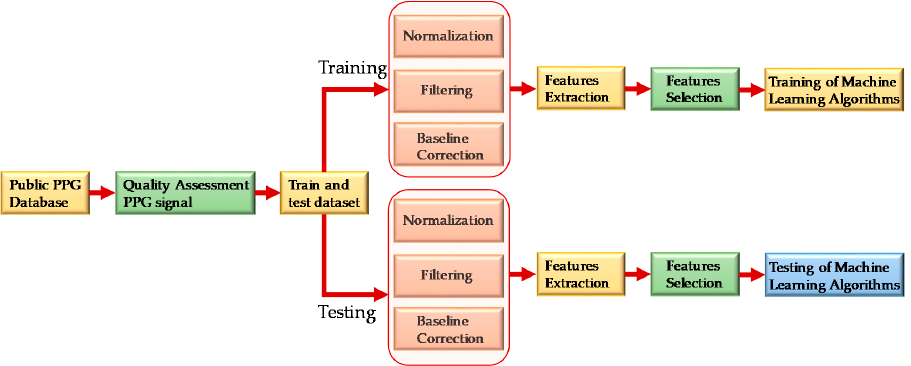
Figure 2. Overall system block diagram.